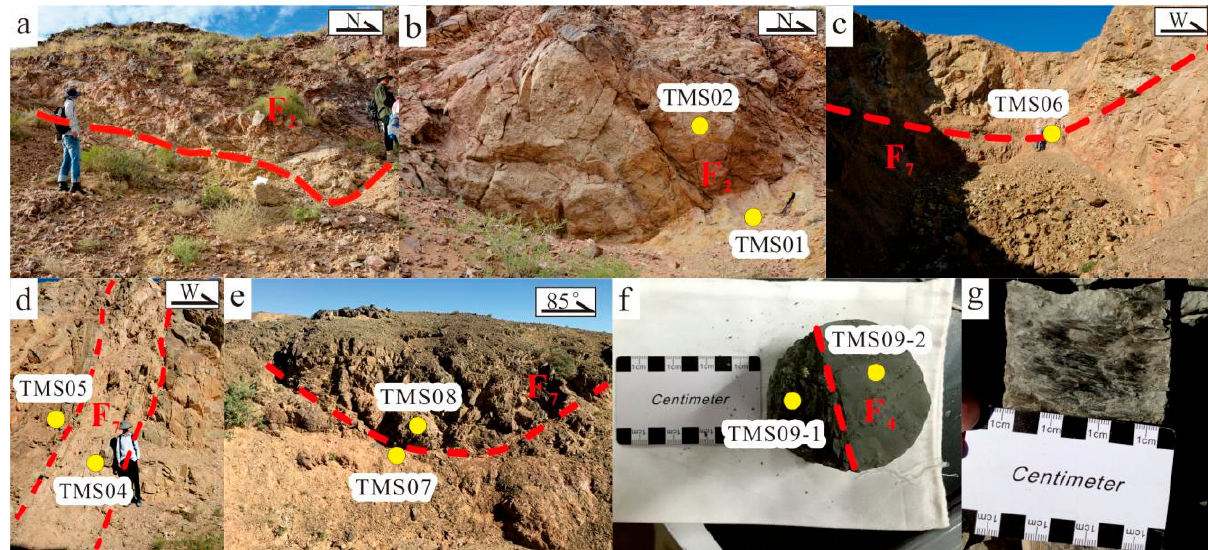
Figure 2. Field outcrops and sampling sites of faults. ( a ) western outcrop of F 2 fault; ( b ) F 2 fault sampling location; ( c ) F 7 fault outcrop one sampling location one; ( d ) F7 fault outcrop one sampling location two; ( e ) F 7 fault outcrop two sampling location; ( f ) F 4 fault samples in drilling core; ( g ) contact surface between fault gouge and host rock of F 4 fault.